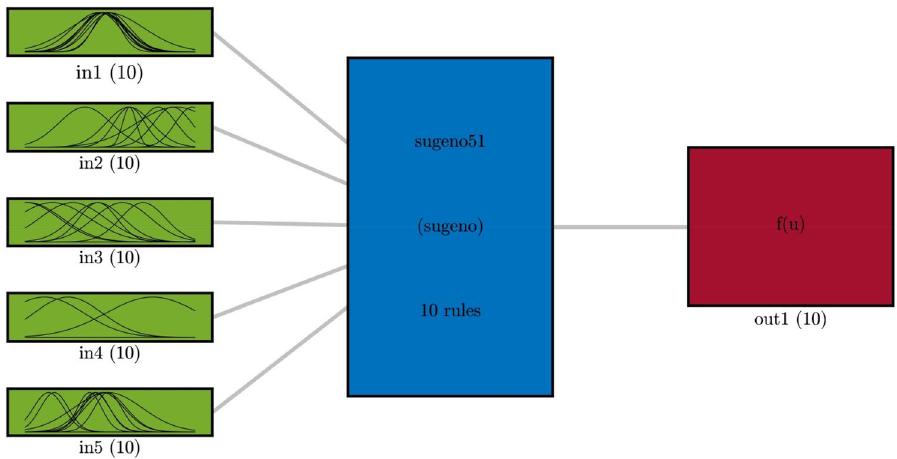
Figure 7. GAFIS structure in the best result of